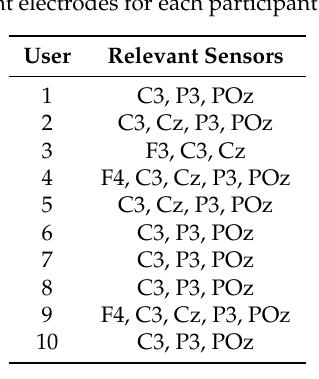
Table 3. Relevant electrodes for each participant in Dataset